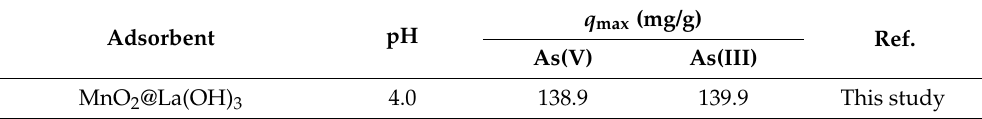
Table 3. Comparison of the maximum adsorption capacities of As(V) and As(III) onto some